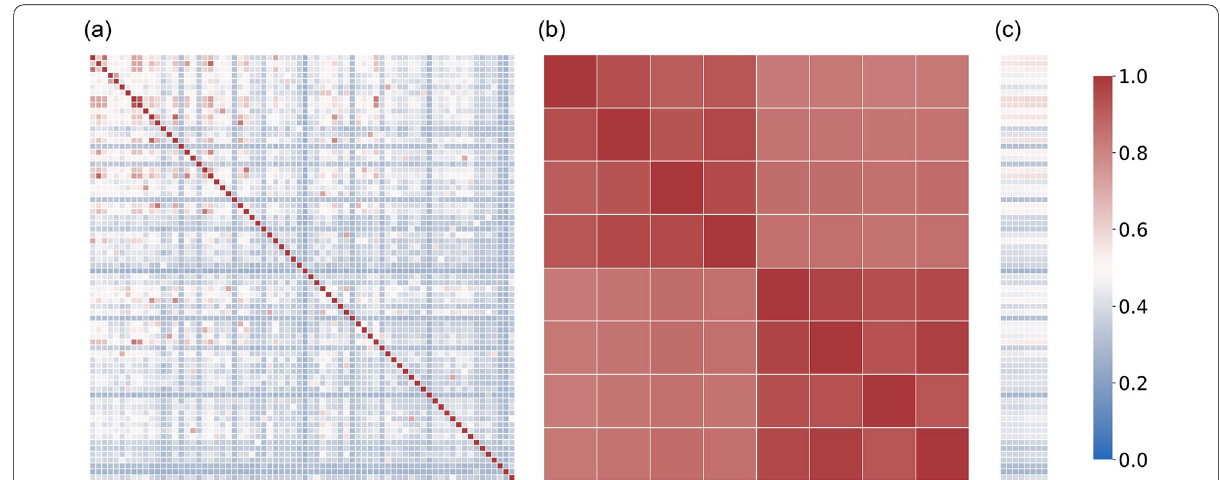
Fig. 4 Graphical display of the correlations between all feature sets. Mean pairwise Pearson correlation between ( a ) deep, ( b ) generic, ( c ) deep and generic feature sets. Red colors correspond to higher correlations and blue colors to lower. The mapping is the same for all three figures and is displayed in the legend at the